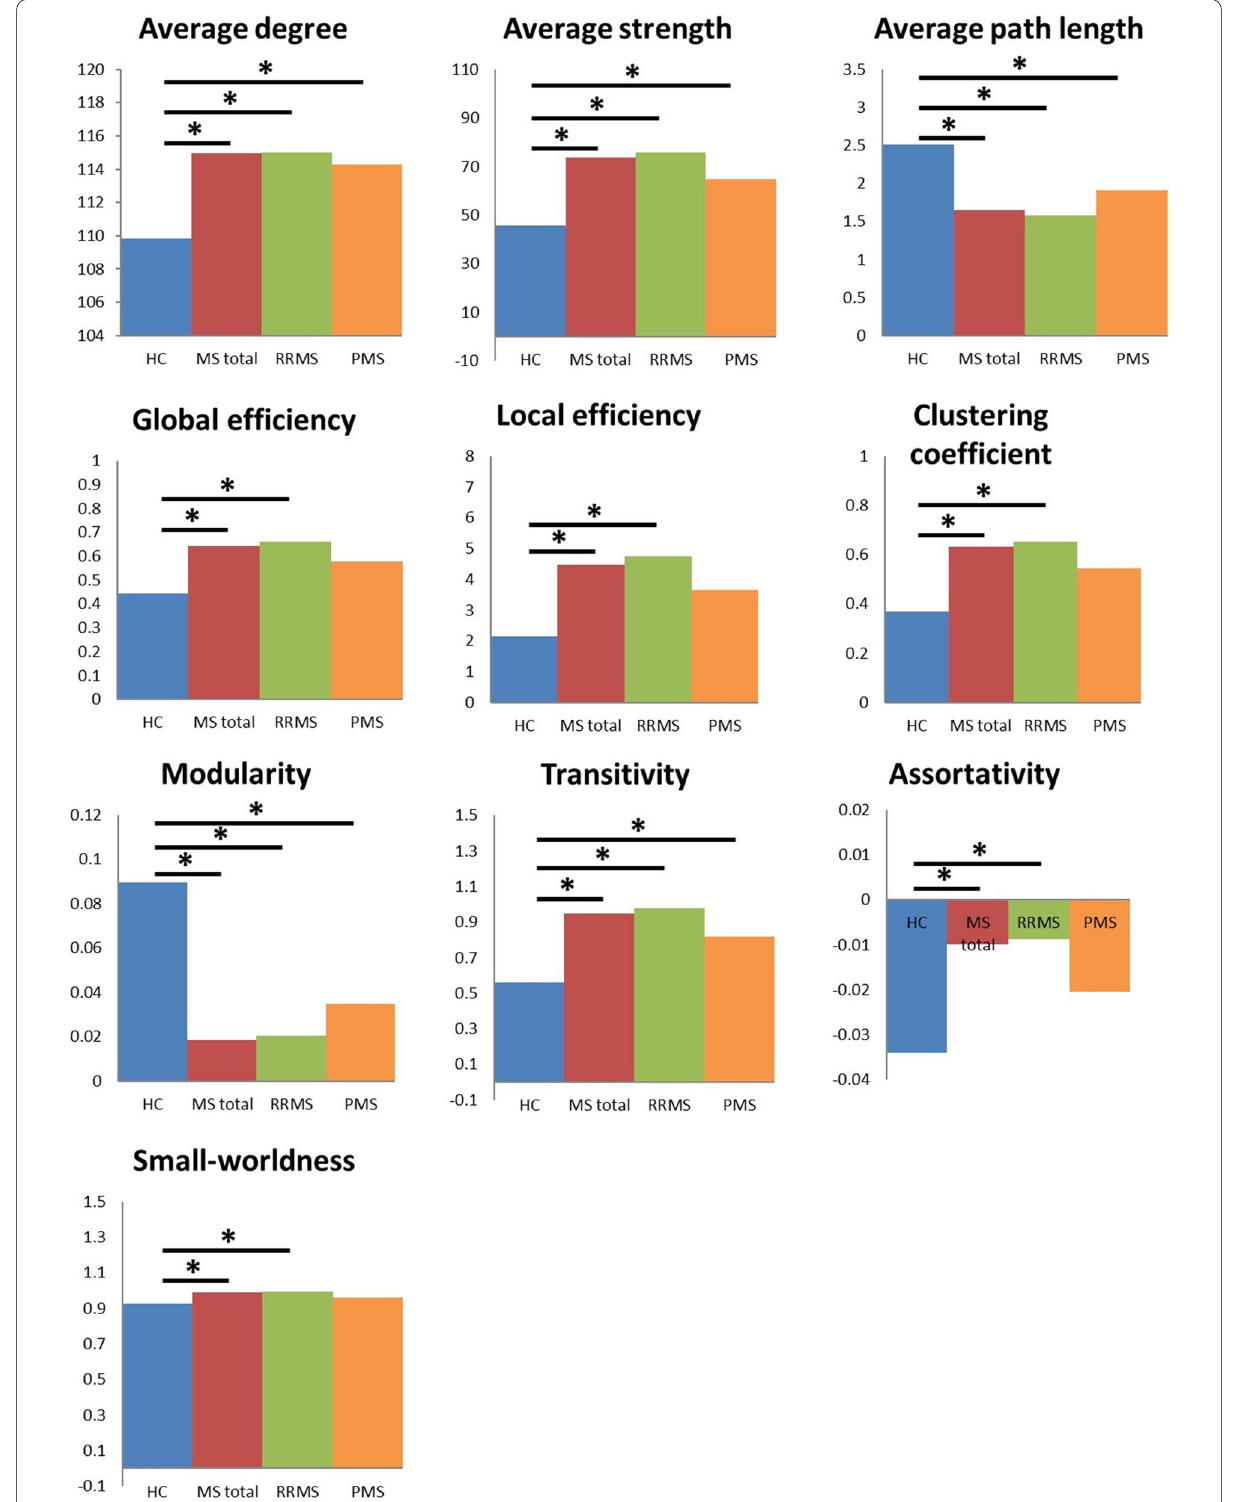
Fig. 5 Group differences using lesion filled T1w data in global graph theoretical network parameters of structural connectomes. Comparisons that have been made were HC versus MS total, HC versus RRMS, HC versus PMS, and RRMS versus PMS. Significant differences are indicated with an asterisk